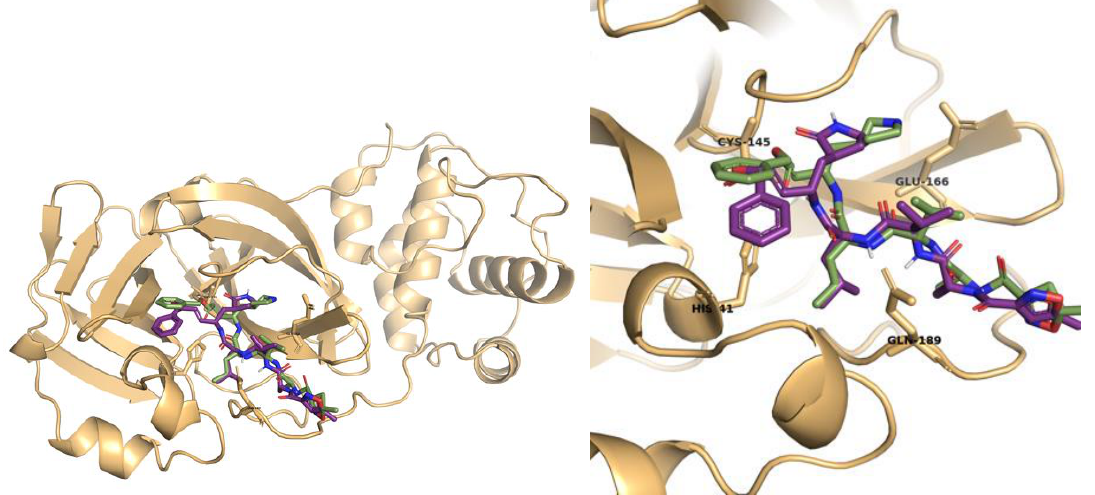
Figure 1. Superimposition of the re-docked (purple) and crystallographic (green) N3 ligand poses. RMSD analyses and analysis of interactions showed that N3 ligand was successfully re-docked and that hydrogen bonds with such residues as Gly 143, Ser144, Cys145, Glu166, Gln189, Thr190, and Pi-Alkyl interactions with His41 and Ala191 were observed (Figure 2).